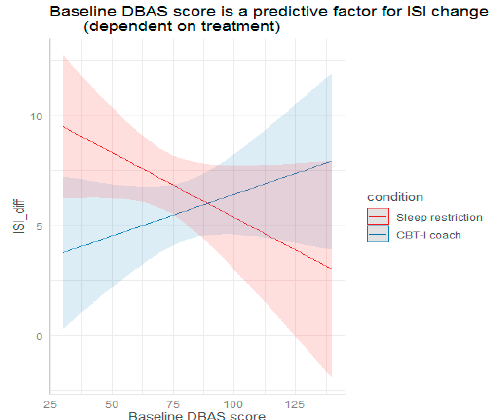
Figure 3. Predictive value of baseline dysfunctional beliefs and attitudes about sleep for ISI change in different arms. ISI—insomnia severity index, CBT-I coach—internet-delivered multicomponent cognitive behavioral therapy for insomnia, ISI_diff—the difference of the ISI from pre-to post-treat- ment (ISI pre-treatment − ISI post-treatment), DBAS—dysfunctional beliefs and attitudes about sleep